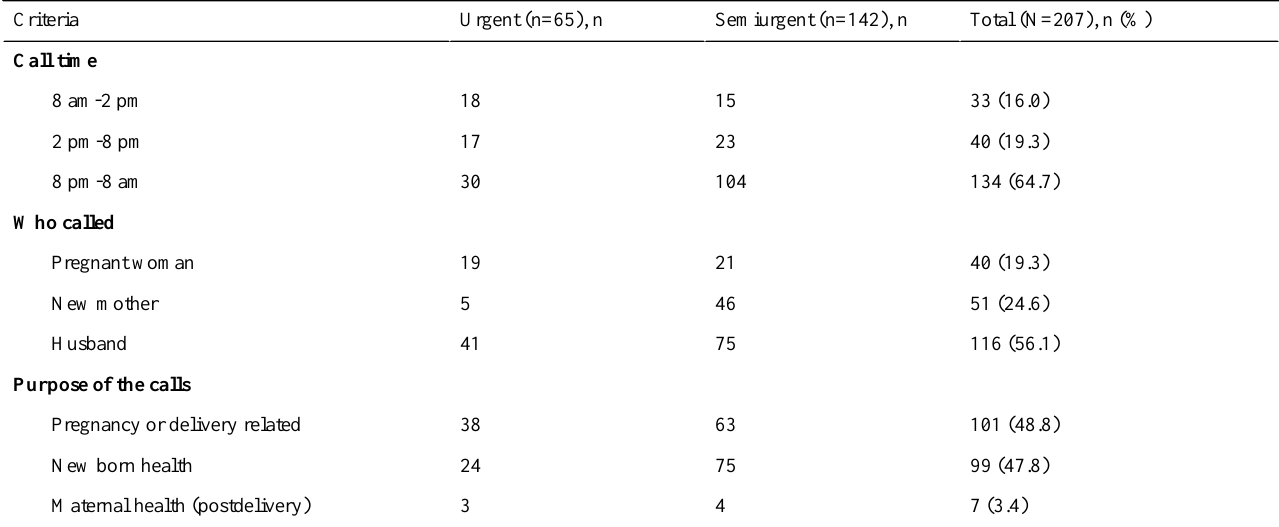
Table 3. Morphology of emergency (urgent and semiurgent) calls